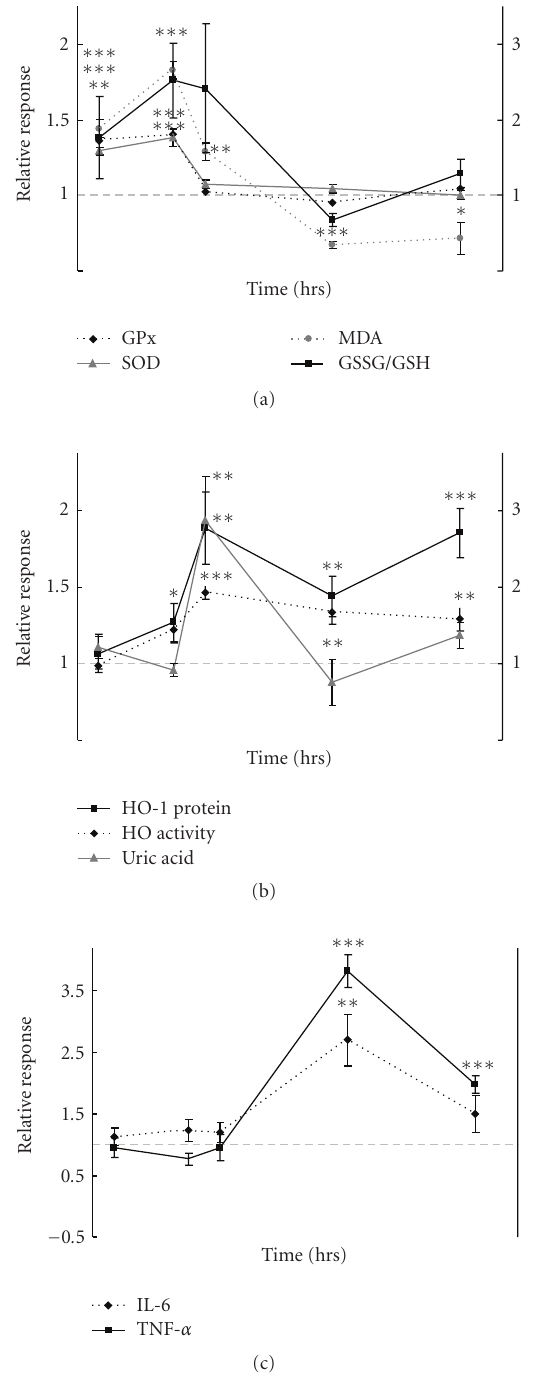
Figure 1: Oxidative stress and inflammation responses in samples from rats exposed to DEE. Relative response of markers, as depicted in legend boxes, at various time points ( t = 4, 18, 24, 48, and 72h) after termination of a 2-hour exposure of rats ( n = 10 per time point and exposure) to DEE. (GSSG/GSH response is indicated by right y-axis). Relative response is defined as the mean value of the DEE exposed group divided by the mean value of the sham exposed group at the same time point. Error bars indicate the standard error of the mean, corrected for the error introduced by the normalization. ∗ , ∗∗ , ∗∗∗ significantly di ff erent from control at P < . 05, < .01, < .001, respectively.